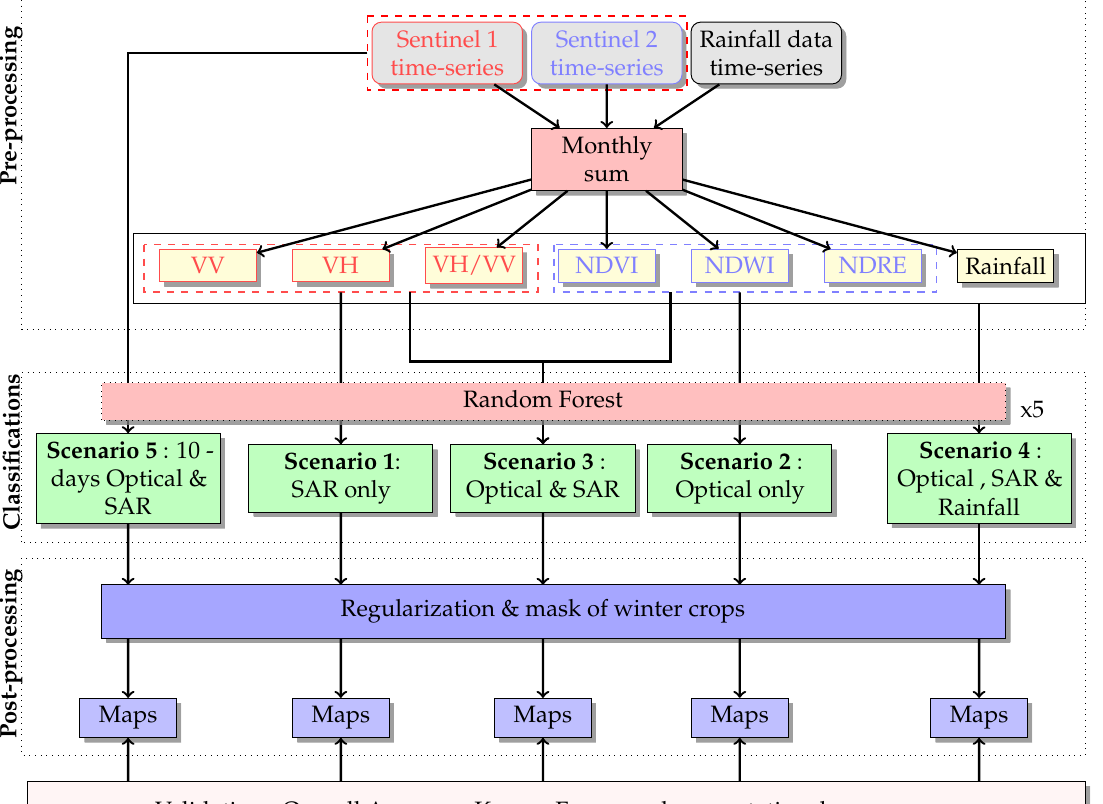
Figure 2. The workflow of the methodology used in this study. The grey squares represent the initial data. The yellow squares are the stacks of monthly cumulative indices after processing by the algorithm, represented by a red square. The green squares correspond to the different scenarios tested. The blue squares represent different maps from the classifiers, i.e. classifications and confidence maps ( NDVI > 0.8 and NDWI < 0.40) . This difference is stronger in 2017. It decreases when entering the 136 − senescent phase. The growing cycle is quite synchronous for all crops, as shown in the table 1. For 137